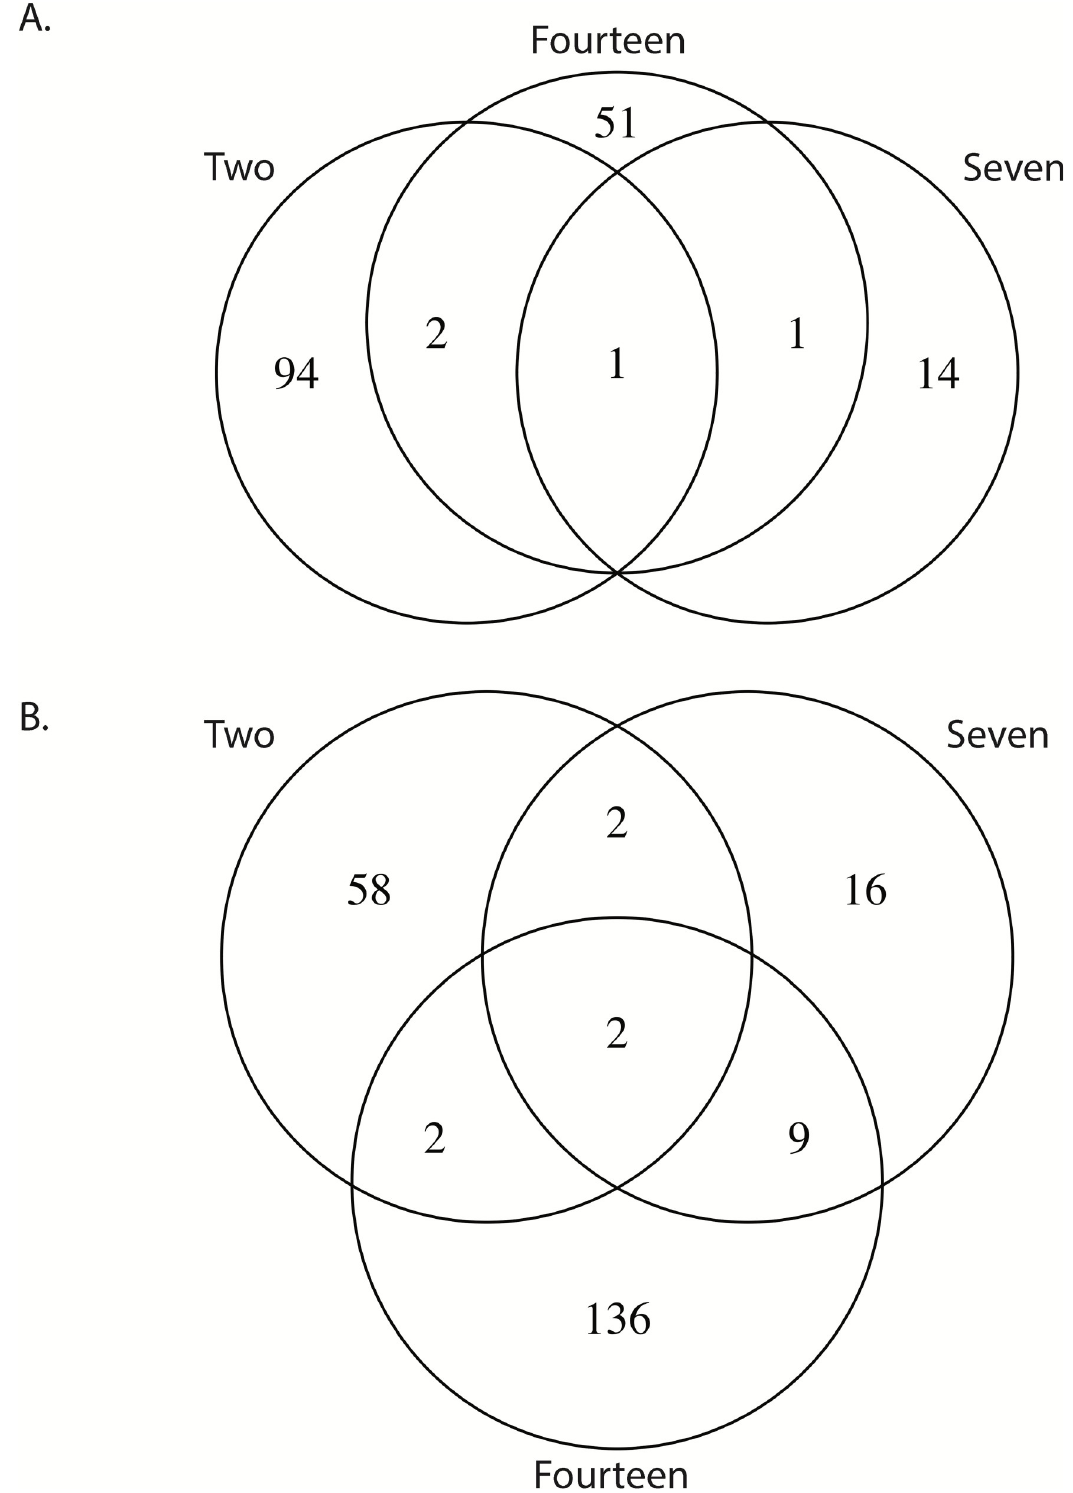
Fig 3. Venn diagrams representing the number of shared transcripts differentially expressed at 2, 7, and 14 dpi. A. represents the repressed transcripts and B. represents the enriched transcripts.